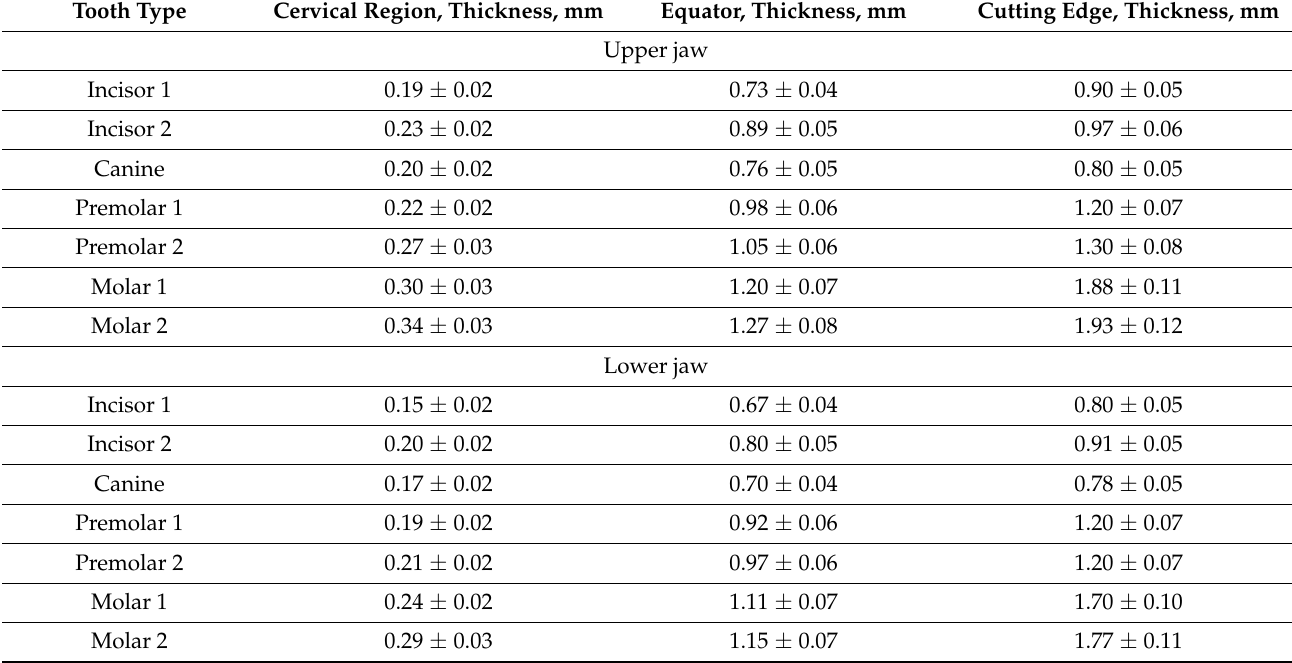
Table 2. Enamel thickness in the cervical region, equator, and the cutting edge. Scanning electron microscopy (SEM) method